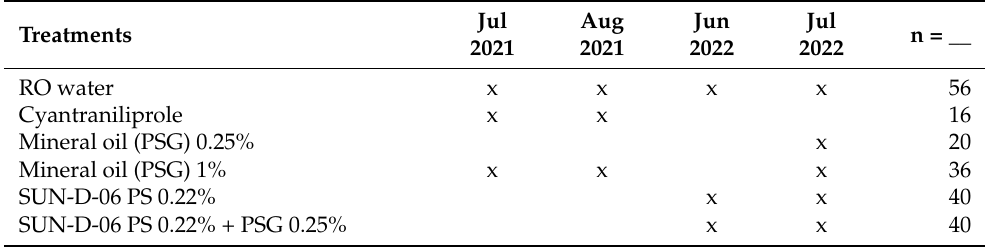
Table 2. Treatments evaluated for efficacy WFT in contact assays conducted during 2021–2022. ‘x’ indicates the specific treatment was evaluated in the assay conducted during the month/year the column represents. ‘n’ indicates the total number of replicates for each treatment. Treatments